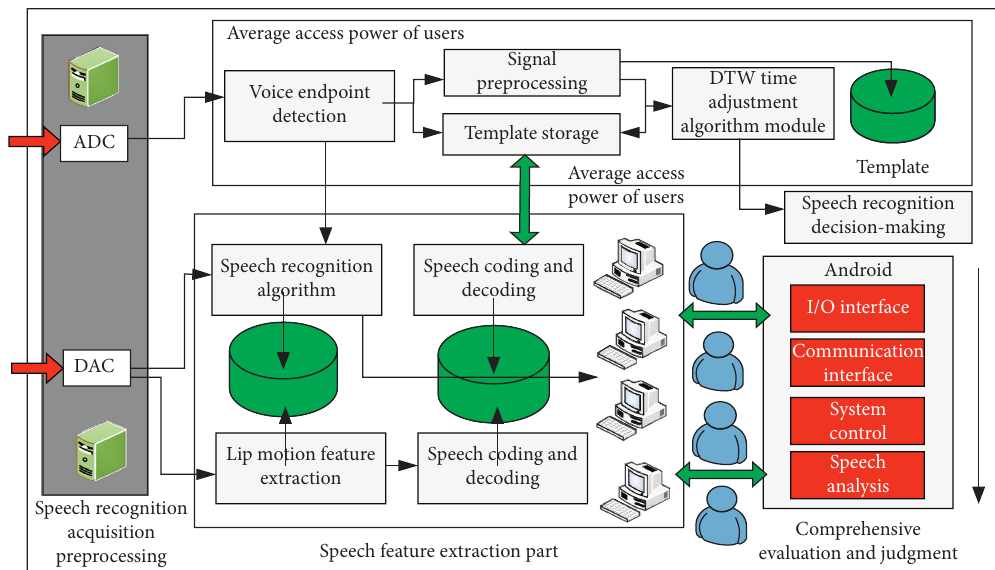
Figure 1: Framework of the speech recognition technology core algorithm of spoken English pronunciation training